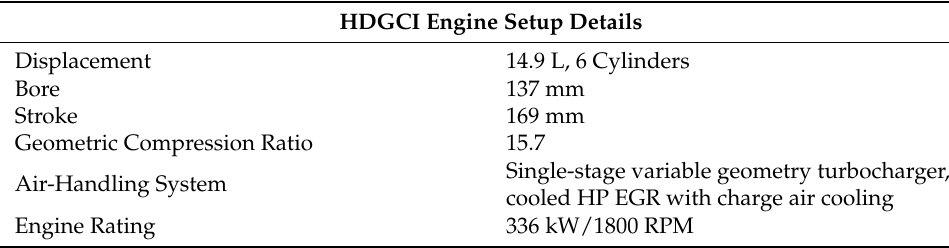
Table 1. Engine specifications.